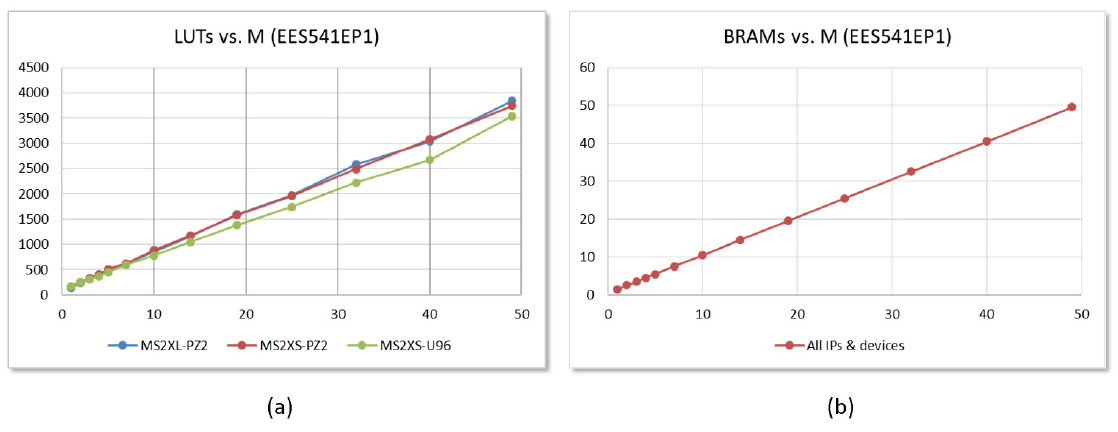
Figure 13. LUTs ( a ) and Block RAMs ( b ) required to implement the MS2XL and MS2XS hardware accelerators on Zynq-7000 and Zynq UltraScale+ devices for the parameter set EES541EP1 and different values of M